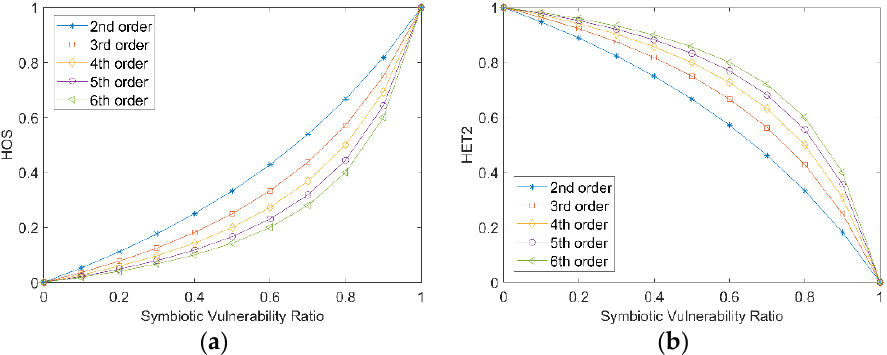
Figure 7. The impact of symbiotic vulnerability ratio. ( a ) The impact on HOS ( b ) The impact on HET2